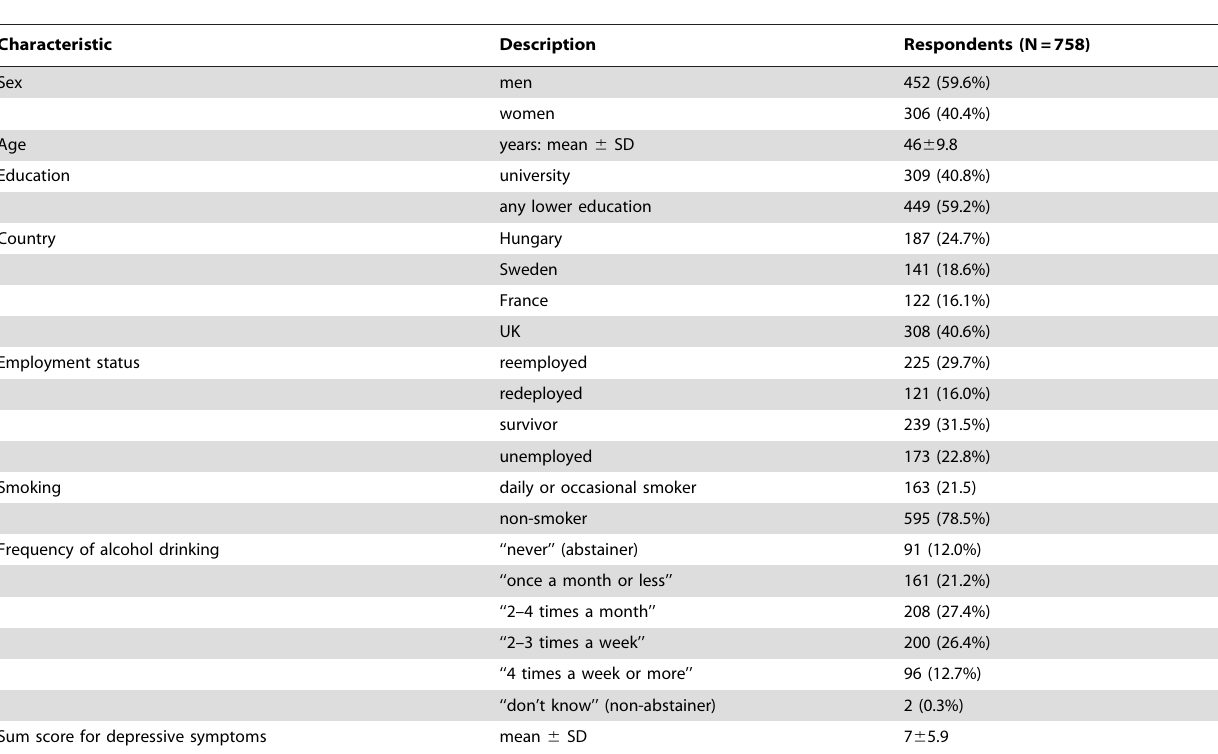
Table 1. Characteristics of study participants who experienced downsizing, data are mean (SD) and number (%).